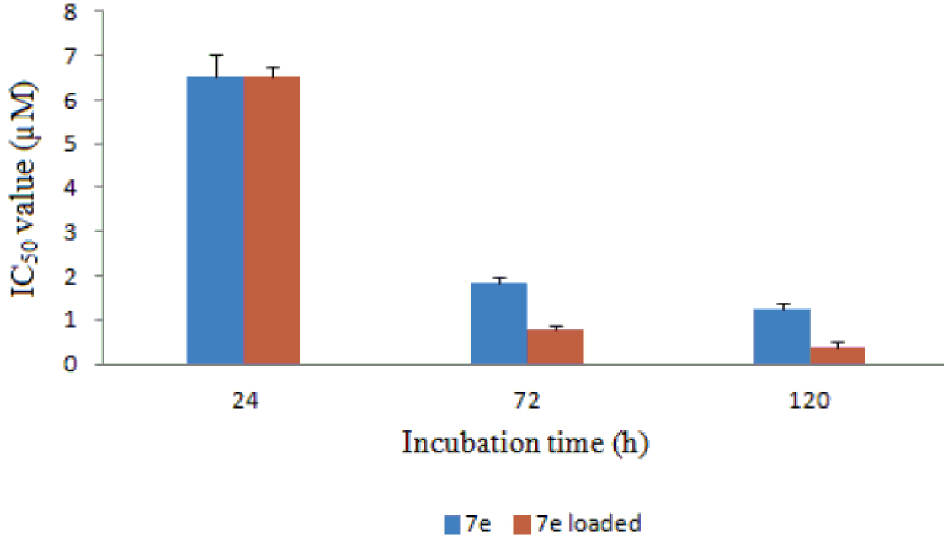
Fig 14. The IC 50 values of the free 7e and 7e-PLGA loaded microspheres.